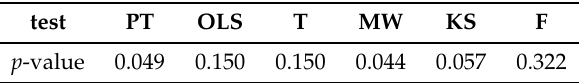
Table 5. P-values of the six tests to detect efficiency difference in groups of male and female students in terms of learning time and achievement in